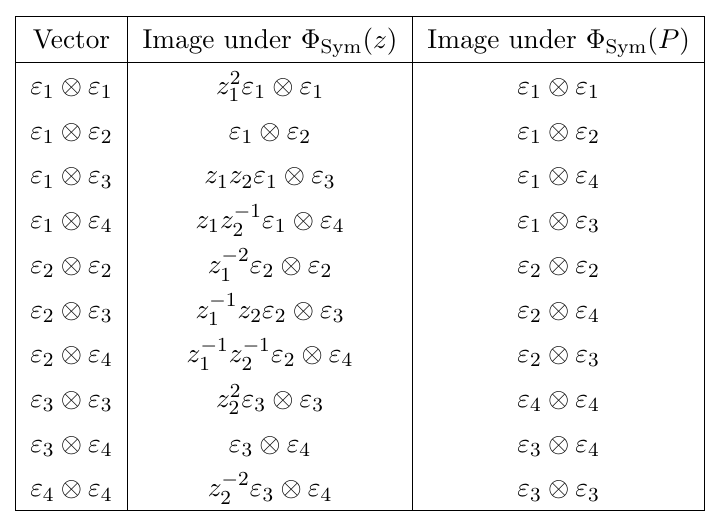
Table 6 . Detail of the computation of (cid:8) Sym ( z ) and (cid:8) Sym ( P ) in